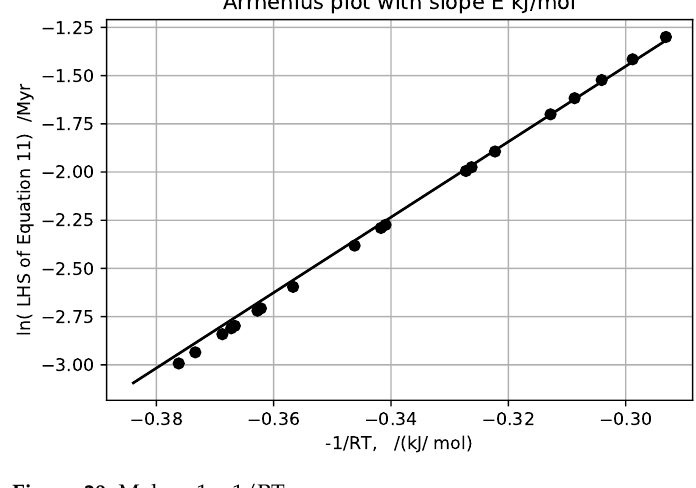
Figure 20. Makran1 − 1/RT.